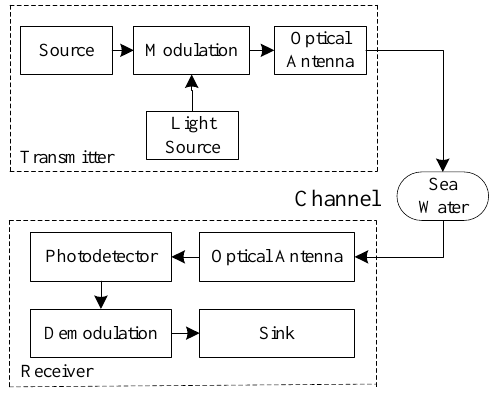
Figure 3. System design for UWOC